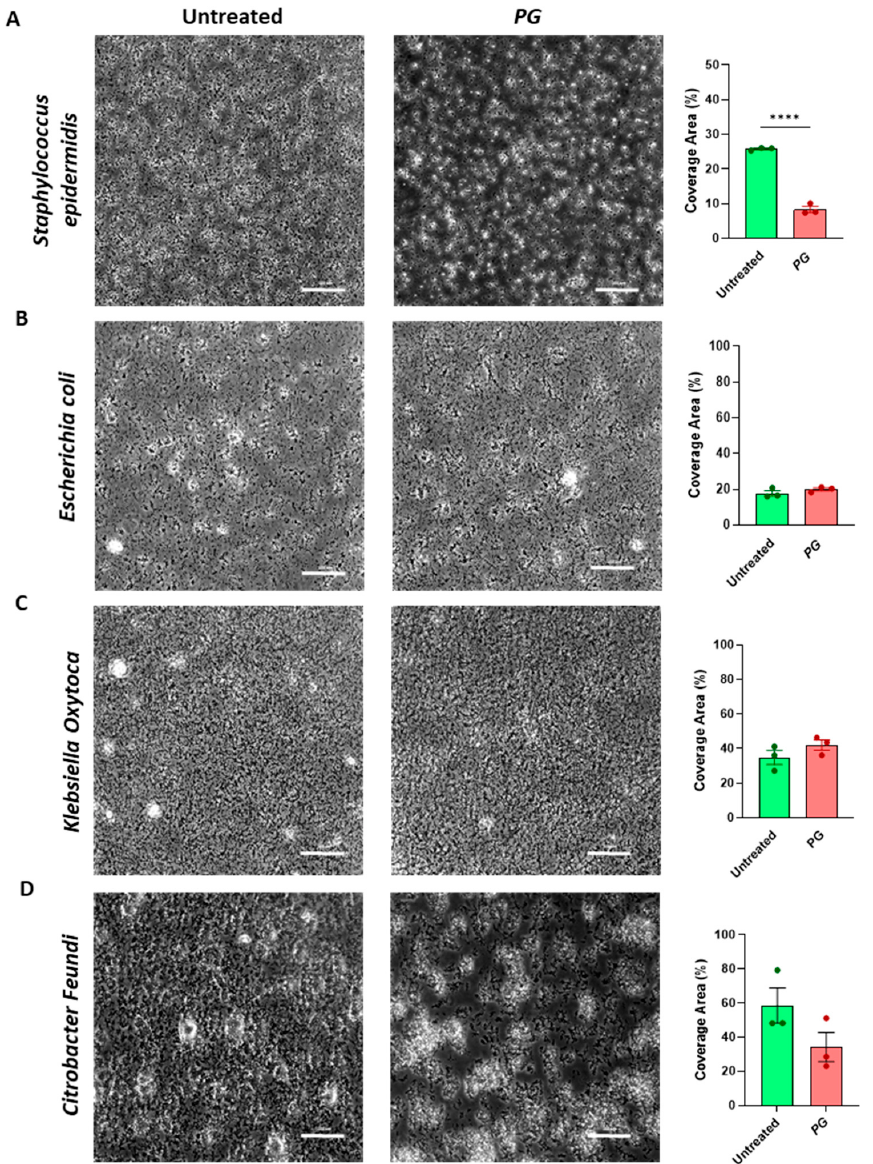
Figure 4. PG -mediated microbial biofilm. Biofilm formation was evaluated in ( A ) Staphylococcus epidermidis , ( B ) Escherichia coli , ( C ) Klebsiella oxytoca , and ( D ) Citrobacter freundii calculating the % of bacterial surface coverage from phase-contrast images. Data are presented as mean ± SEM. Unpaired t -test. **** p < 0.0001. n = 3/group.